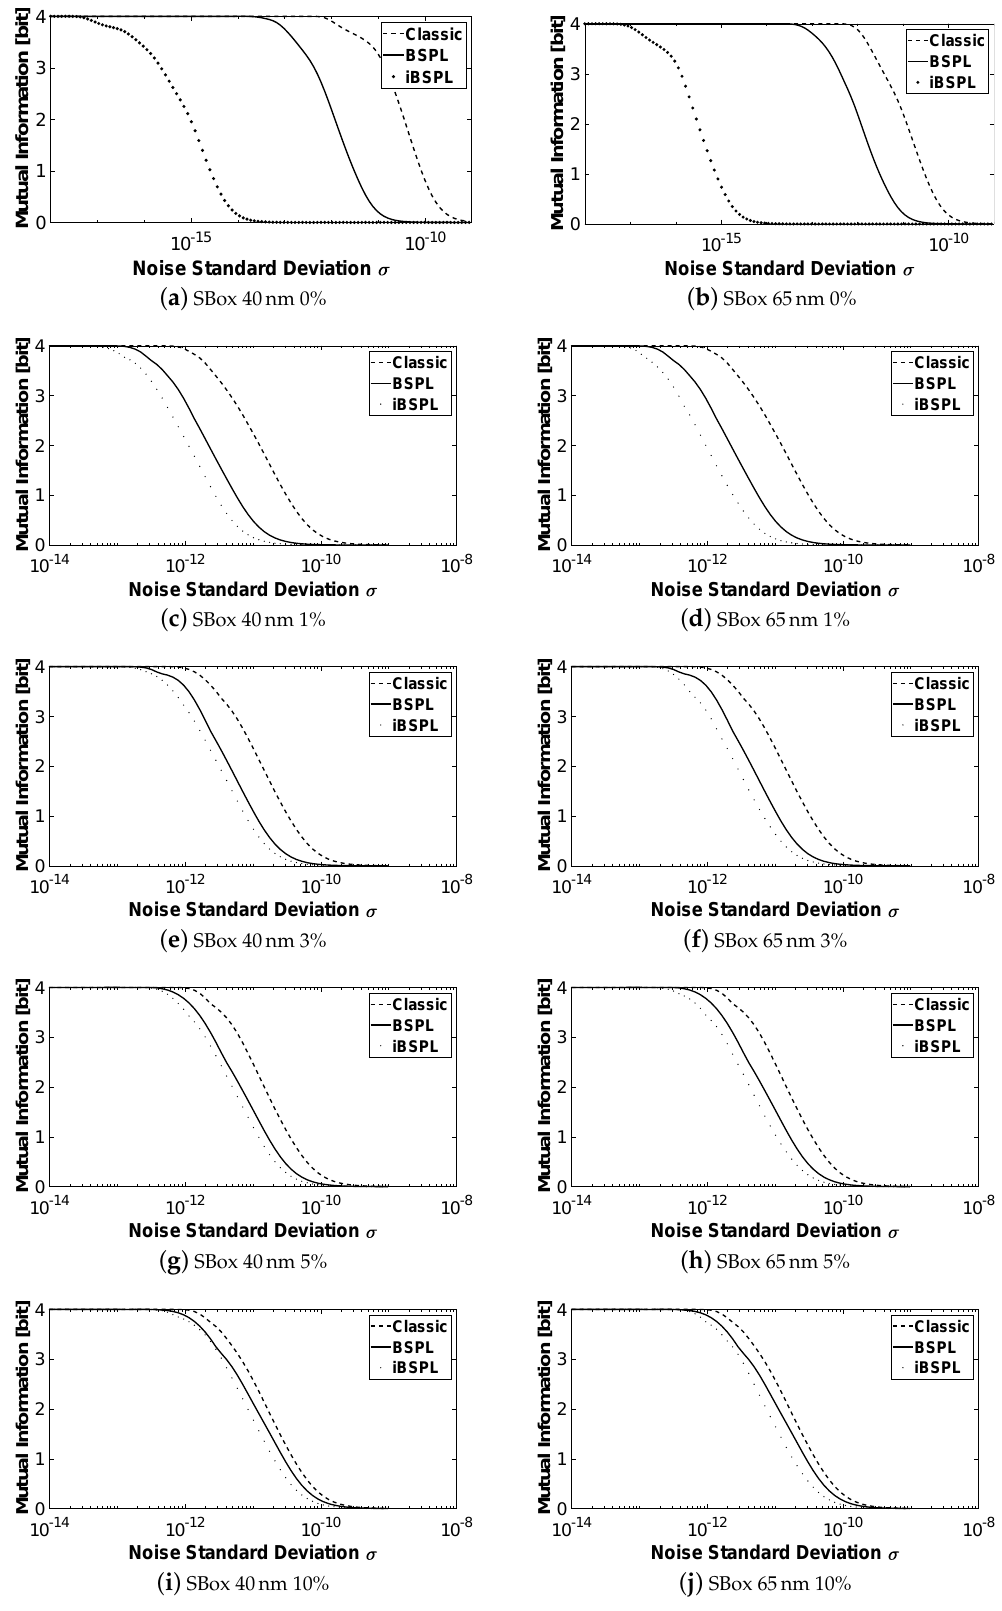
Figure 10. Information theoretic analysis of the PRESENT SBox synthesized in Classic, BSPL or iBSPL logic gates for different levels of process variations